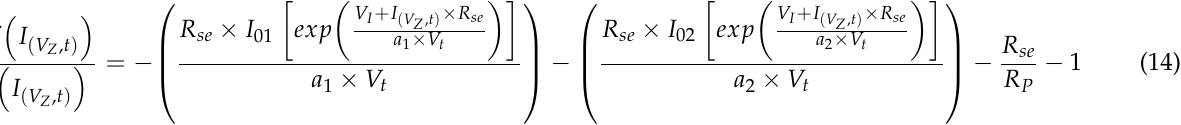
Table 2 for three different case studies. Case 1, RTC France solar cell; Case 2, Photowatt-